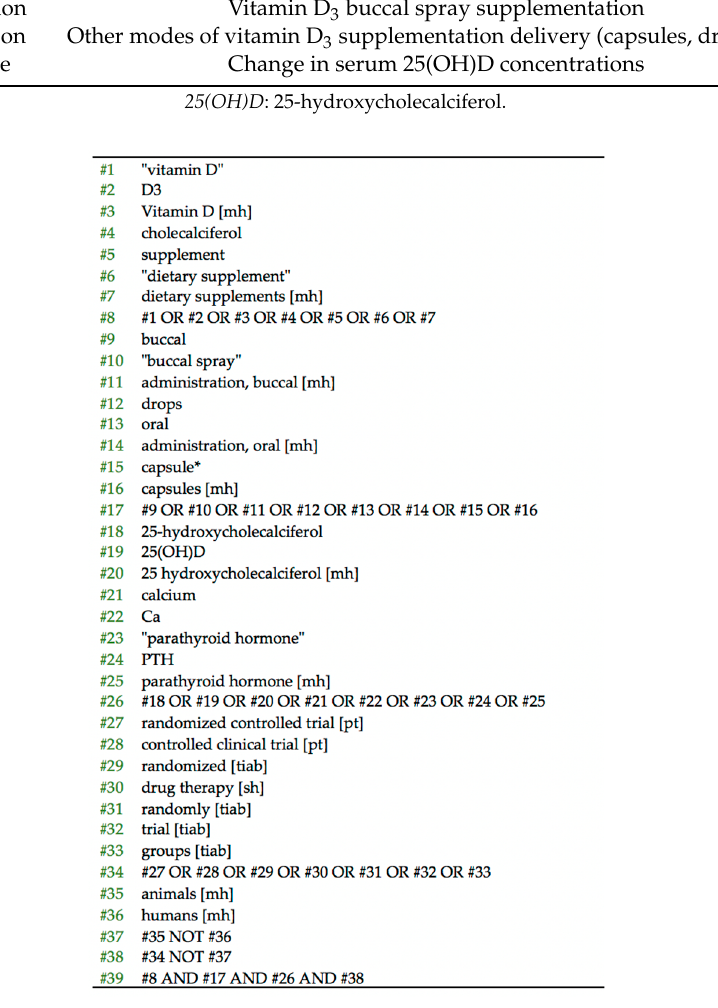
Figure 1. PubMed search strategy.